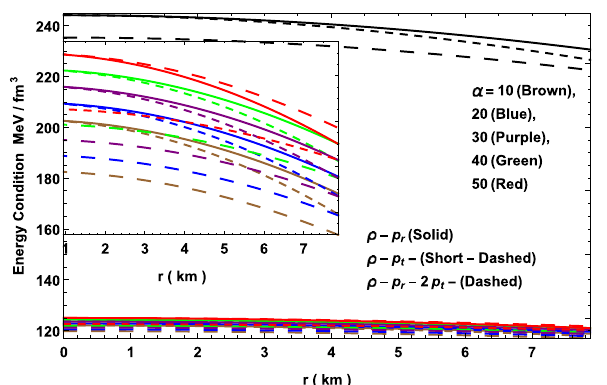
Fig. 12 The M – I graphs are plotted for a = 2 . 13 × 10 − 4 and b = 4 × 10 −